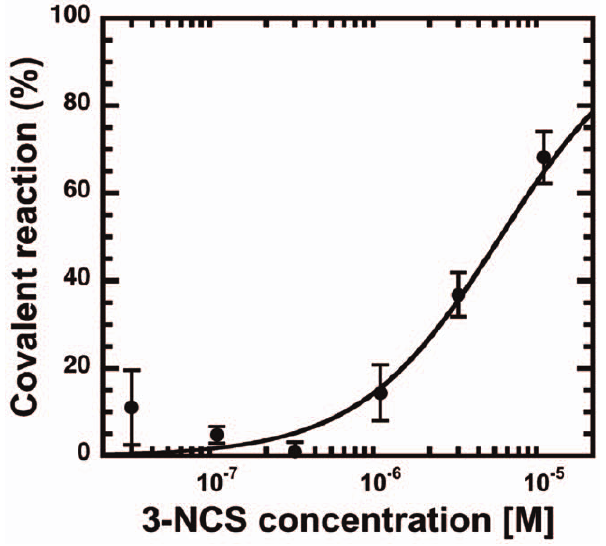
Figure 4. Concentration dependence at the binding level. Concentration dependence of the covalent reaction of the 3-NCS at Fig. 3. Data are shown as mean 6 SD for three experiments each (triplicates of each point in each experiment).